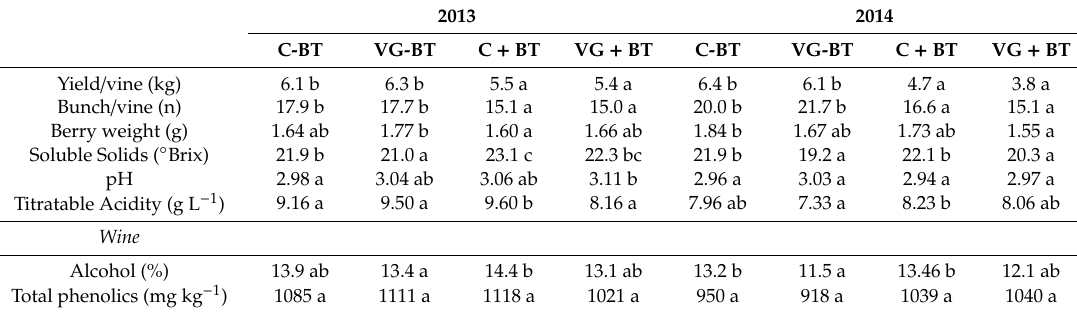
Table 1. Yield components, juice and wine composition of Falanghina samples treated with Vapor Gard (VG) and / or bunch thinned (BT) and of the relative controls (C). Values have been collected during two growing seasons, 2013 and 2014. Data are averages of 10 replicates for yield and number of bunches per vine and averages of 4 repetitions for other parameters. For each parameter and for each year, row values with the same letter are not significantly di ff erent by Duncan’s post hoc test ( p <